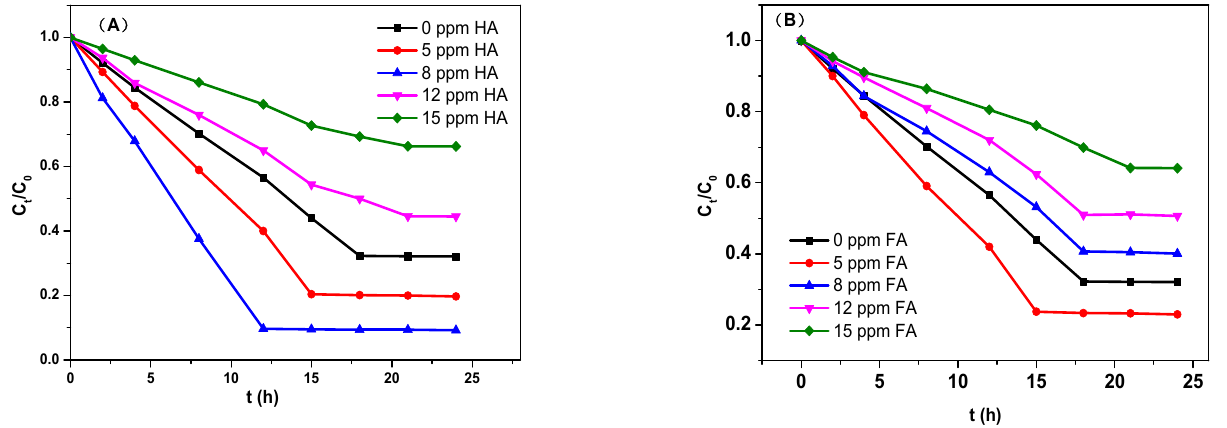
Figure 9. TC sorption behavior on magnetic sludge biochar as a function of the concentration of HA ( A ) and FA ( B ).